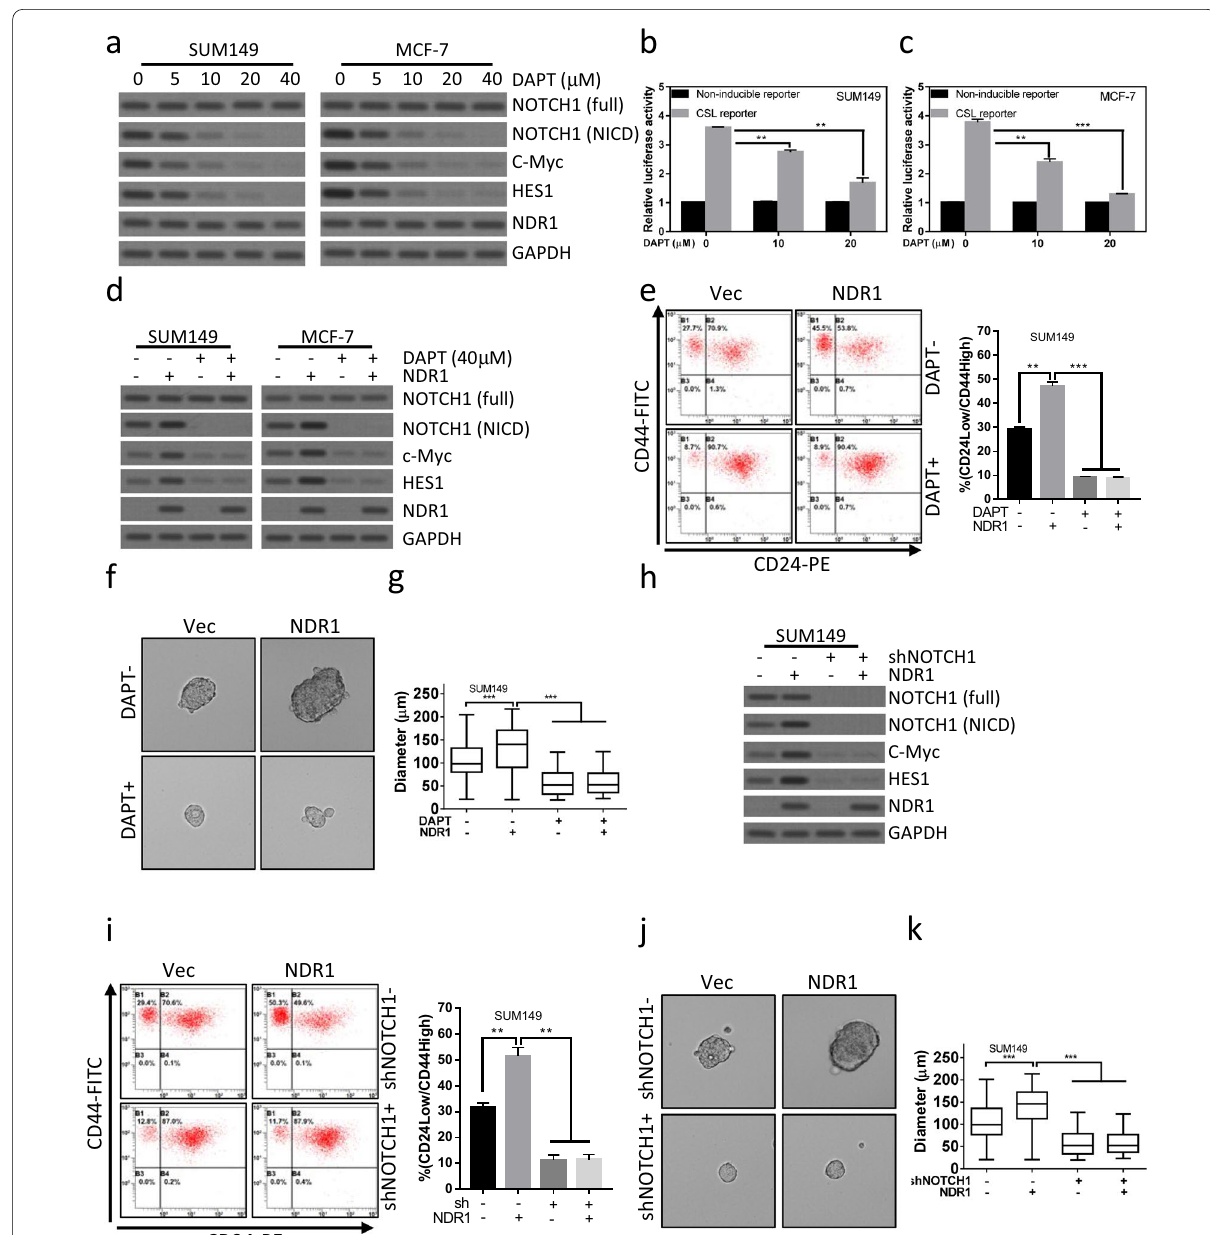
Fig. 4 Activation of Notch1 signaling pathway is essential for NDR1 enhanced cancer stem cell properties in breast cancer cells. a SUM149 or MCF‑7 cells were treated with the indicated concentration of DAPT for 72 h. Cells were harvested and subjected to western blot analysis. b , c SUM149 or MCF‑7 cells were treated with the indicated concentration of DAPT for 72 h. Cells were harvested and subjected to luciferase reporter assay. d NDR1 or control vector were expressed in SUM149 or MCF‑7 cells. Cells were treated with the indicated concentration of DAPT for 72 h. Cells were harvested and subjected to western blot analysis. e–g NDR1 or control vector was expressed in SUM149 cells. Cells were treated with the indicated concentration of DAPT for the indicated time. Cells were harvested and subjected to CD24/44 analysis (72 h, e ) and sphere‑forming assay (7 days, f and g ). The representative spheres were shown in f . The distribution of sphere diameters was shown in g. h NDR1 or control vector was expressed in SUM149 cells. Cells were infected with lentivirus expressed shNotch1 or control shRNA for the indicated time. Cells were harvested and subjected to western blot analysis. i‑k NDR1 or control vector was expressed in SUM149 cells. Cells were infected with lentivirus expressed shNotch1 or control shRNA for the indicated time. Cells were harvested and subjected to CD24/44 analysis (72 h, i ) and sphere‑forming assay (7 days, j and k ). The representative spheres were shown in j. The distribution of sphere diameters was shown in k. The bar represents mean three independent experiments (*: p < 0.05, **: p < 0.01, ***: p <